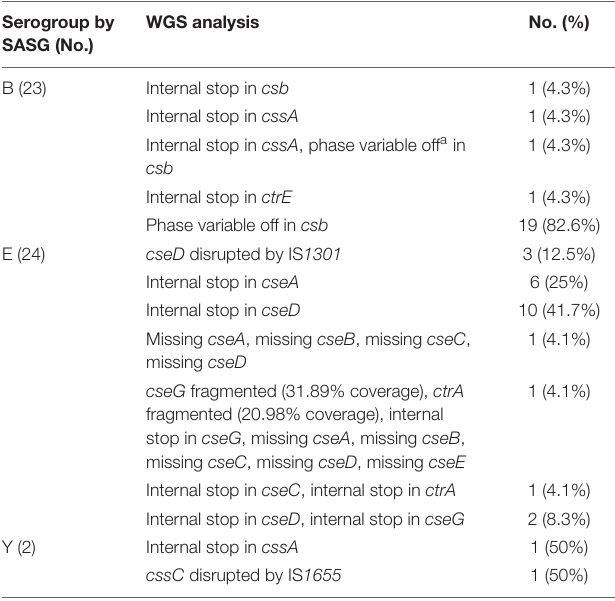
TABLE 2 | The cps mutations in Nm carriage isolates with discrepant capsule typing results. Serogroup by SASG